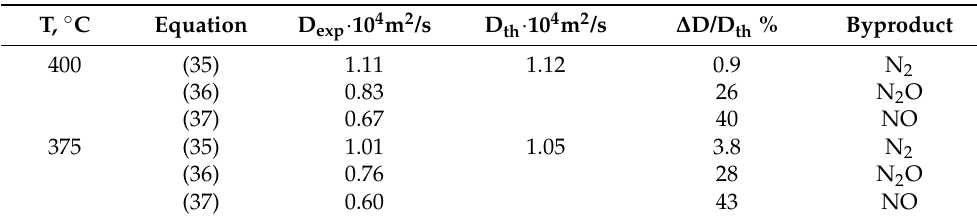
Table 1. Experimental (D exp ) and theoretical diffusion (D th ) coefficients for ammonia in nitrogen at different temperatures